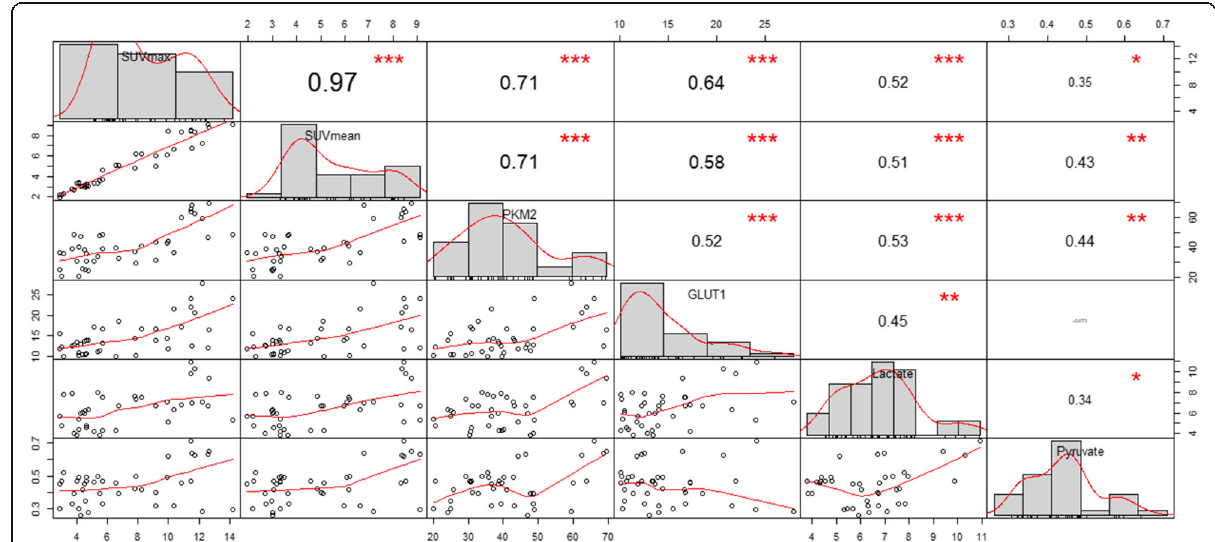
Fig. 7 The diagonal line represents the distribution of each variable, with the correlation coefficient above the diagonal and the correlation curve below the diagonal. * P < 0.05, ** P < 0.01, and *** P <